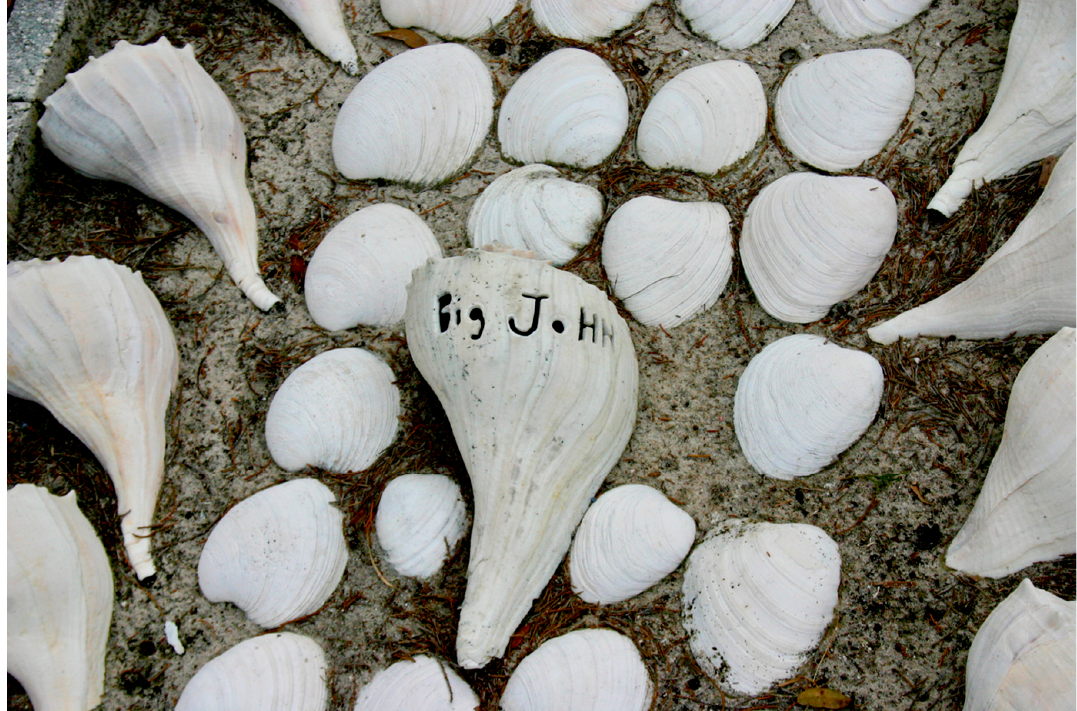
Figure 5. On one of the graves, a large shell is engraved with the words, “Big J. HH”. Photograph courtesy of the author.